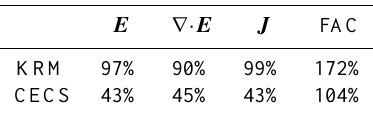
Table 1. Errors in the electrojet results calculated by the KRM and CECS methods. Error is calculated using Eq. (24) and data presented in Figs. 3 and 4.